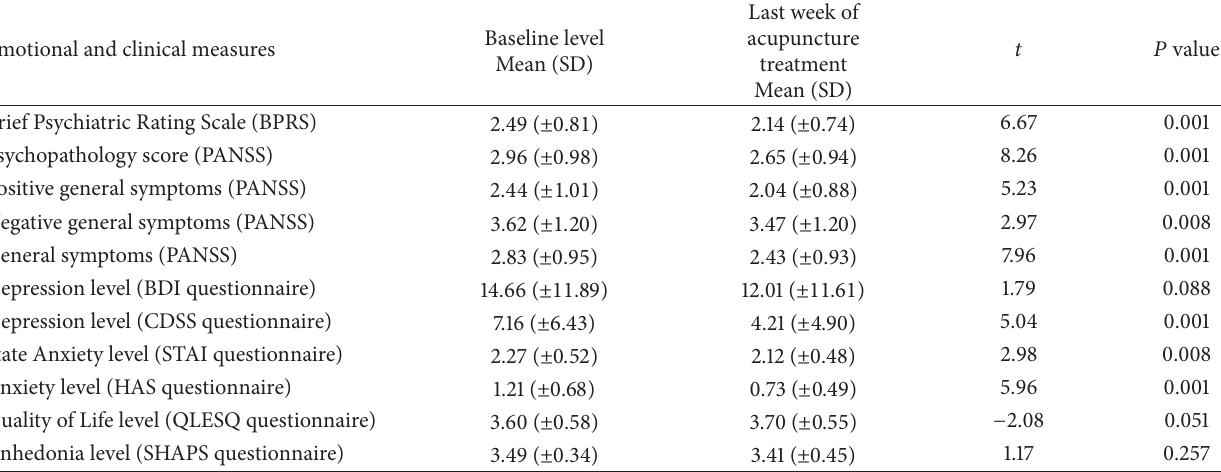
Table 2: Emotional and clinical measures (means and standard deviations) after each phase of the study and analysis of the comparisons between